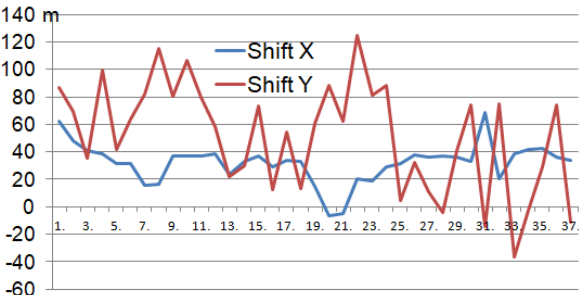
Figure 7: Shifts in the RPC-orientations versus GCPs, frame1 of data set 3, SkySat SSC12, 37 Basic Analytic scenes with 2560 x 1080 pixels of 6.5 µm